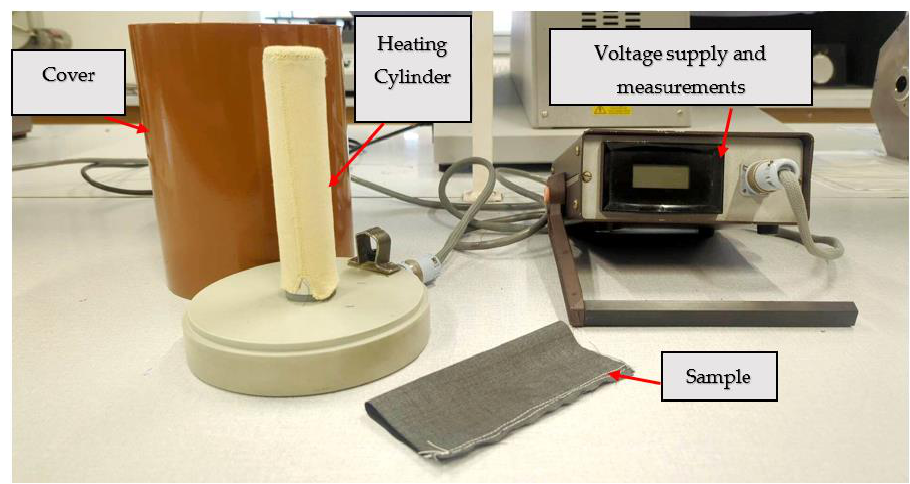
Figure 3. Experimental device for determining adiathermic power.